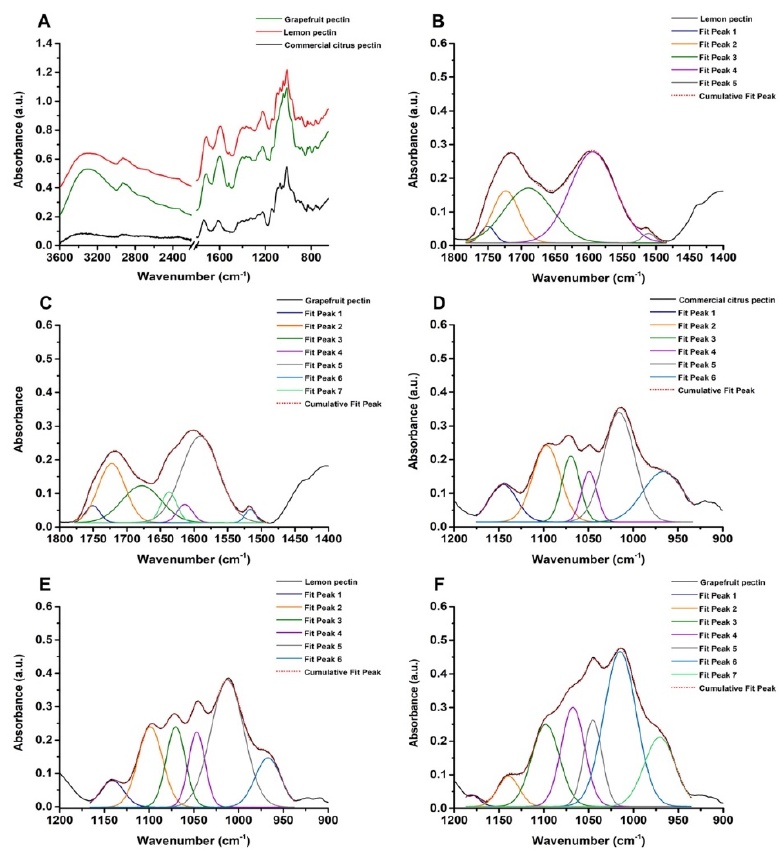
Figure 2. Attenuated total reflectance (ATR)-FTIR spectra collected for lemon and grapefruit IntegroPectin, as well as commercial citrus pectin ( A ) off-set by 0.2 a.u.; spectral deconvolution by non-linear least-squares fitting of lemon ( B ) and grapefruit ( C ) IntegroPectin in the 1800–1470 cm −1 region, alongside commercial citrus pectin ( D ), lemon ( E ) and grapefruit ( F ) IntegroPectin in the 1200–950 cm −1 region.